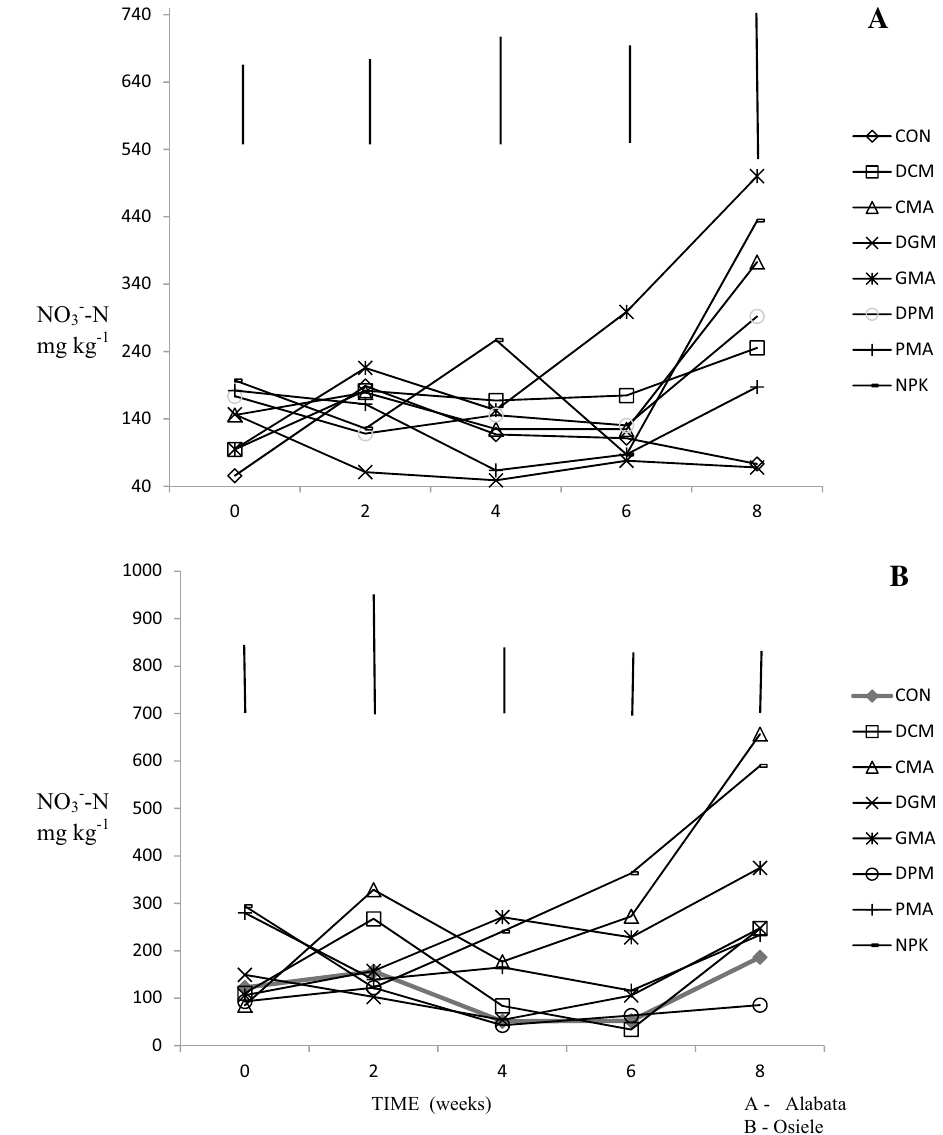
Fig. 5 Changes in nitrate nitro- gen of soils from Alabata and Osiele with incubation